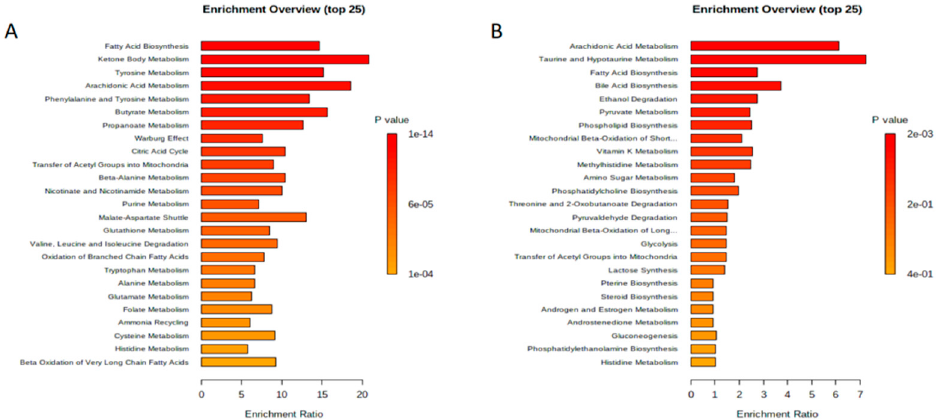
Figure 1. Metabolite set-enrichment analysis (MSEA) of the highest %TWL tertile (T3) at three months post-sleeve gastrectomy compared with all patients at baseline. ( A ) Serum. ( B ) Fecal. Note: A total of 209 fecal and 157 serum metabolites were used for the MSEA.